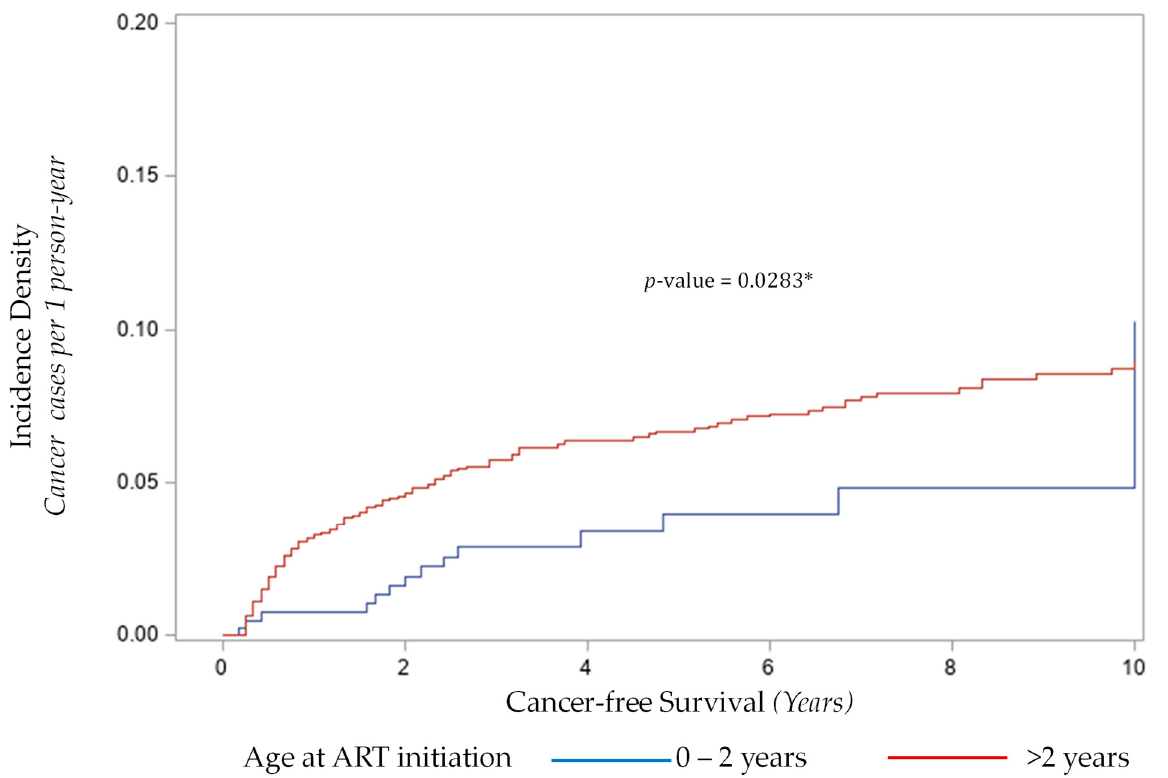
Figure 1. Incidence density function of cancer in children with HIV in BIPAI cohort by age at start of ART. *: p < 0.05